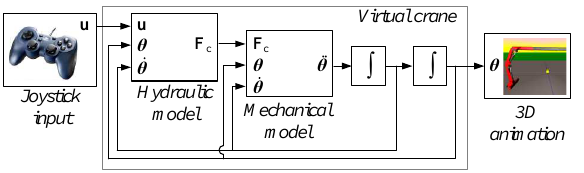
Figure 2: Overview of the simulation